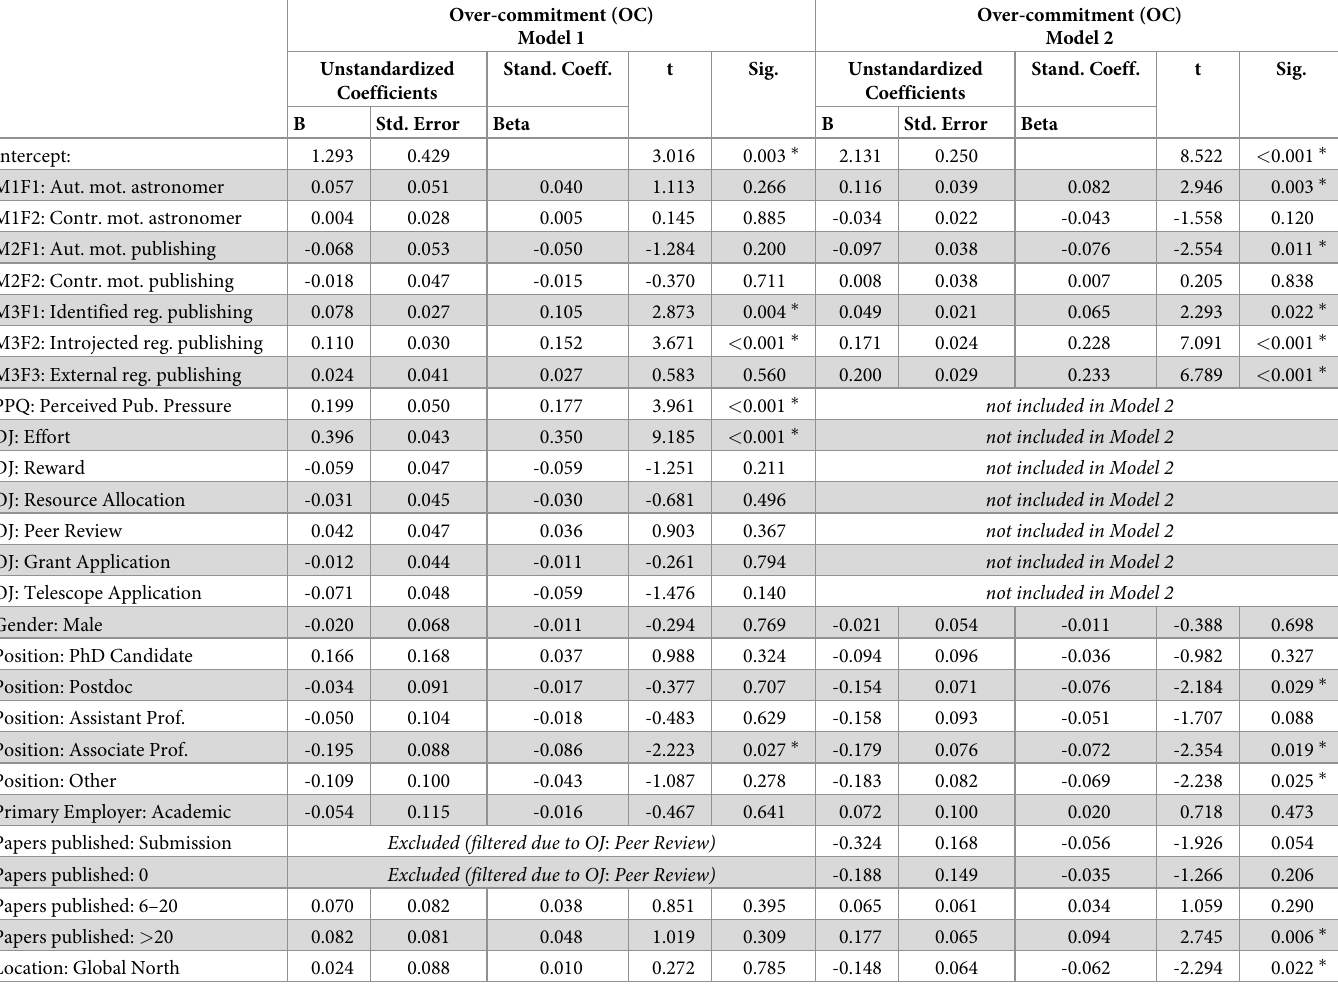
Table 8. Regression models of DV = Overcommitment. Model 1: DV is regressed onto the seven motivational factors, perceived publication pressure, distributive & organizational justice, and the control variables. Model 2: DV is regressed onto the seven motivational factors and the control variables.